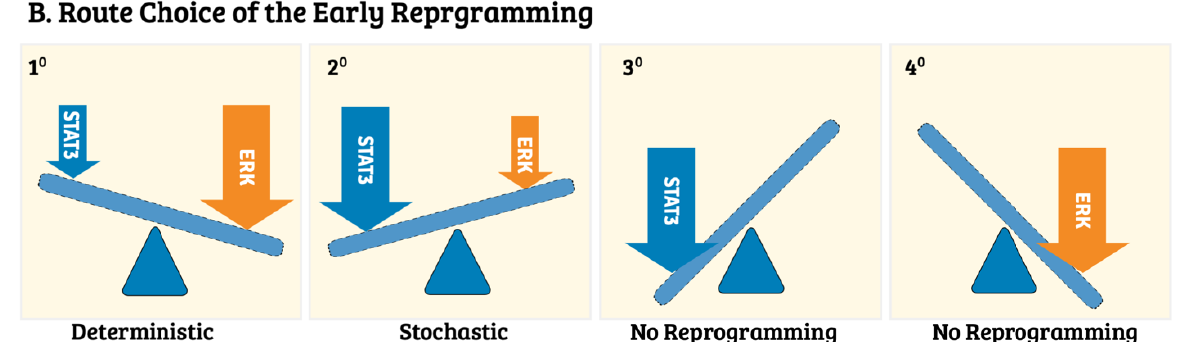
Figure 3. Models of epigenetic reprogramming and their potential mechanism in early route choice. ( A ) Somatic reprogramming takes its action mode at the beginning of epigenetic remodeling. Two well-recognized patterns of reprogramming kinetics, namely stochastic and deterministic models, are used to gain pluripotency-competent cells during somatic reprogramming. Latency in the X-axis indicates the required time or the number of cell divisions to acquire pluripotency, whereas the Y-axis shows the percentage of pluripotent cell numbers. The left panel displays the stochastic model. All of the candidate cells after certain cell divisions have an equal chance of undergoing reprogramming. Therefore, the acquisition of pluripotency is a random event [2,64]. The right pane shows the deterministic model where only the specific cells with a privileged state can overcome the epigenetic barriers set up by the deterministic process. Therefore, it is synchronized with a fixed latency to surpass any encountered hurdle [65 – 67]. ( B ) Liu et al. argued that the onset route choice of reprogramming depends on the balance of the EGFR/ErbB2 and LIFR/gp130 pathways. In the 1° panel, input signals more on the EGFR/ErbB2 pathway endow a group of synchronized cells to surpass the reprogramming barrier. In contrast, if they rely more on the LIFR/gp130 pathway, the stochastically unsynchronized cells gain pluripotency at their own pace (2° panel). Eliminating the inputs from either of the signal pathway fails to achieve pluripotency (3° and 4° panels). Thus, different modes of operation can reversibly act on the same MEF cells through modulating the activity of STAT3 and Erk.